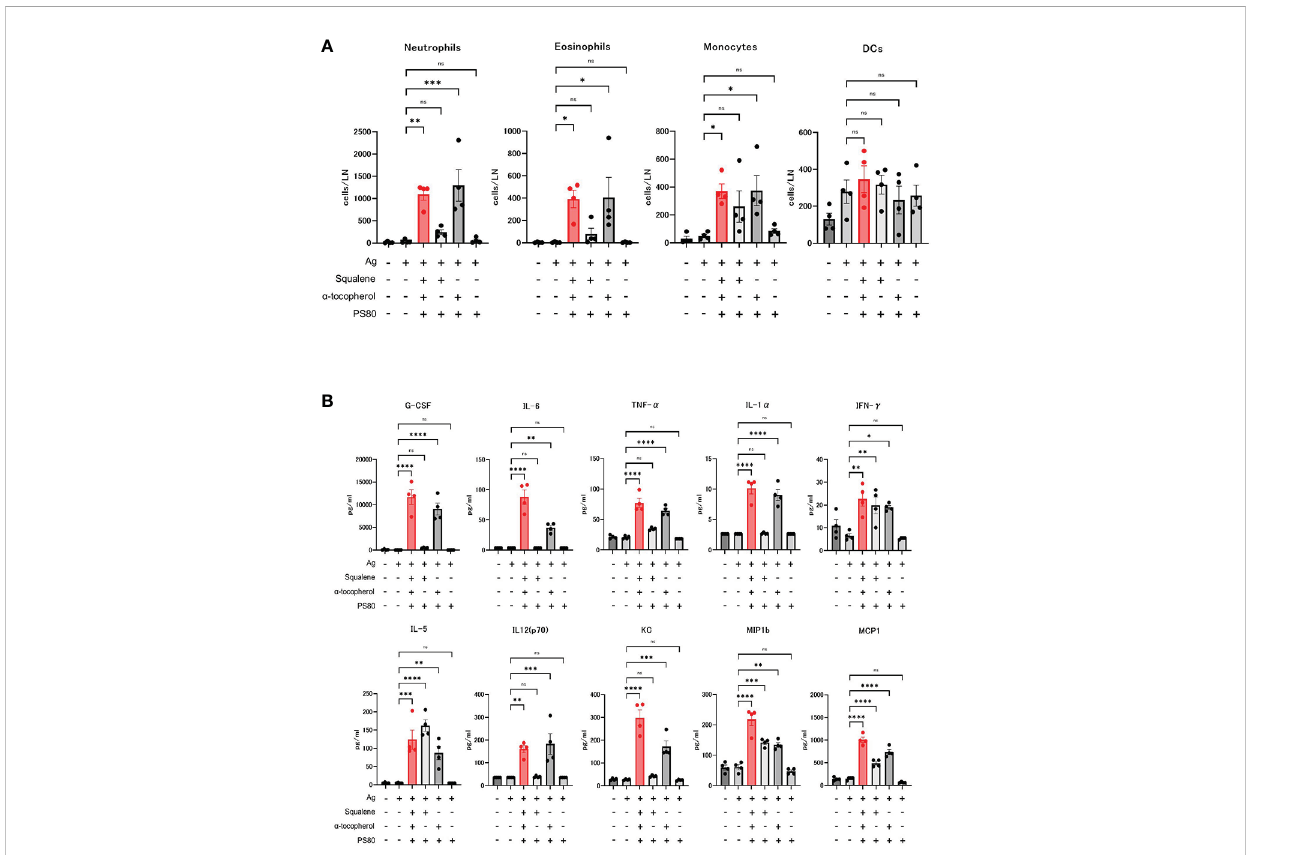
FIGURE 5 Activation of innate immune responses by a -tocopherol. (A) The number of neutrophils, eosinophils, monocytes, and dendritic cells (DCs) in draining lymph nodes at 16 hours post-administration of each adjuvant or vehicle (n=4/group). Each bar represents the mean; error bars indicate the standard error of the mean. Each circle represents the number of in fl ammatory cells in individual mice. (B) Granulocyte-colony stimulating factor (G-CSF), IL-6, TNF- a , IL-1 a , IFN- g , IL-5, IL-12 (p70), KC, macrophage in fl ammatory protein 1b (MIP1b), and monocyte chemoattractant protein-1 (MCP1) concentrations in sera at 16 hours post-administration of each adjuvant or vehicle (n=4/group). Each bar represents the mean; error bars indicate the standard error of the mean. Each circle represents the cytokine and chemokine concentrations in individual mice. Statistical signi fi cance was determined using Tukey ’ s multiple comparison test (ns, P ≥ 0.05, *P<0.05, **P<0.01, ***P<0.001, and